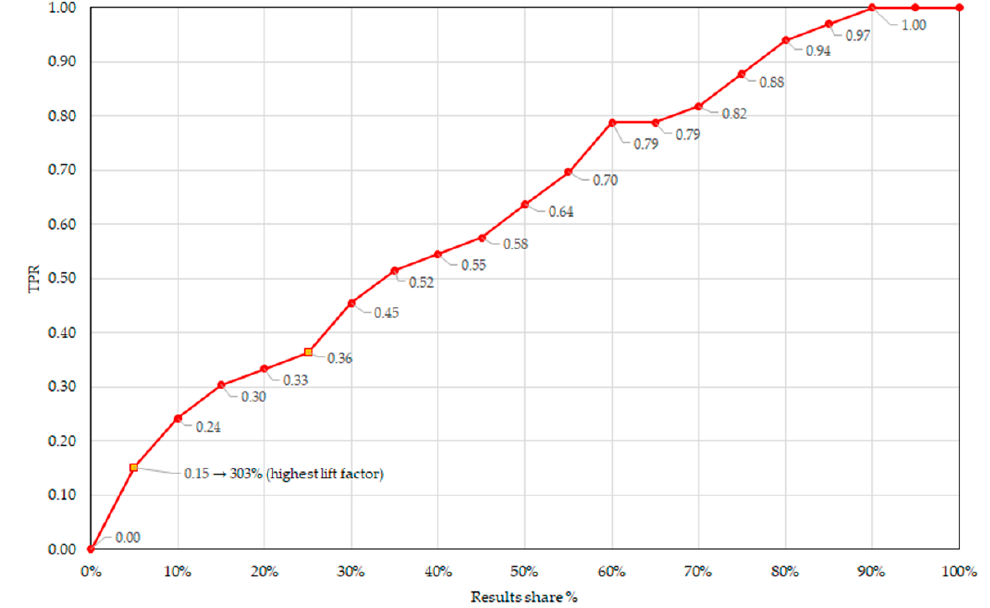
Figure 1. An example of a realistic lift chart from the evaluation experiment described in Section 5. The dataset was queried with two keywords and instances were ranked by approximate lexical similarity. Optimal precision was achieved for the first 5% of emotionally annotated pictures in the set, while the optimal recall ( > 90% of true positive examples) was ensured by using the top 80% ranked results.